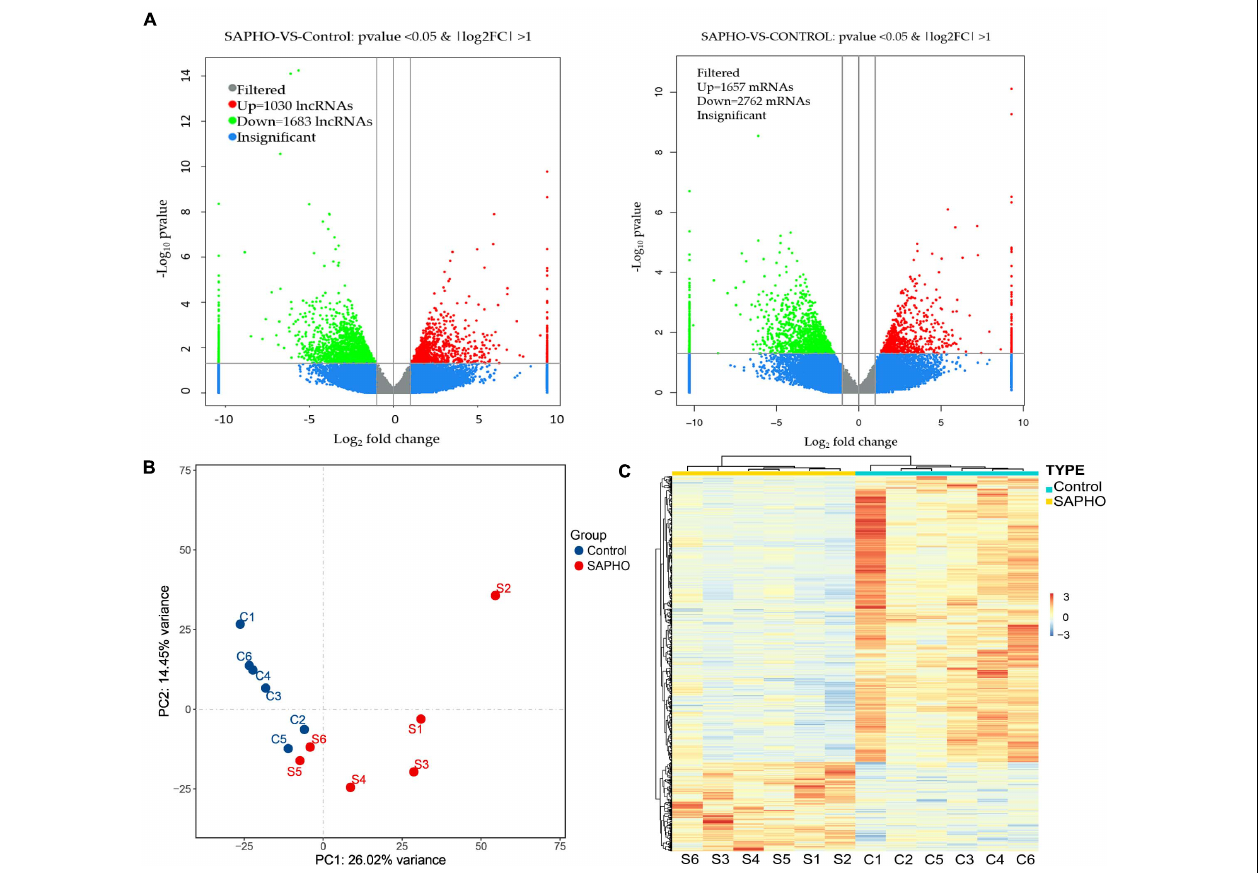
FIGURE 2 | Differentially expressed lncRNAs and mRNAs in patients with SAPHO syndrome. (A) The differentially expressed lncRNAs (left) and mRNAs (right) were identified using a cutoff as “twofold expression difference and p -value < 0.05.” (B) PCA map of all samples in control and SAPHO group. (C) Hierarchical clustering analysis of DE lncRNA-targeted DE mRNAs in SAPHO patients showed closer relationship within both